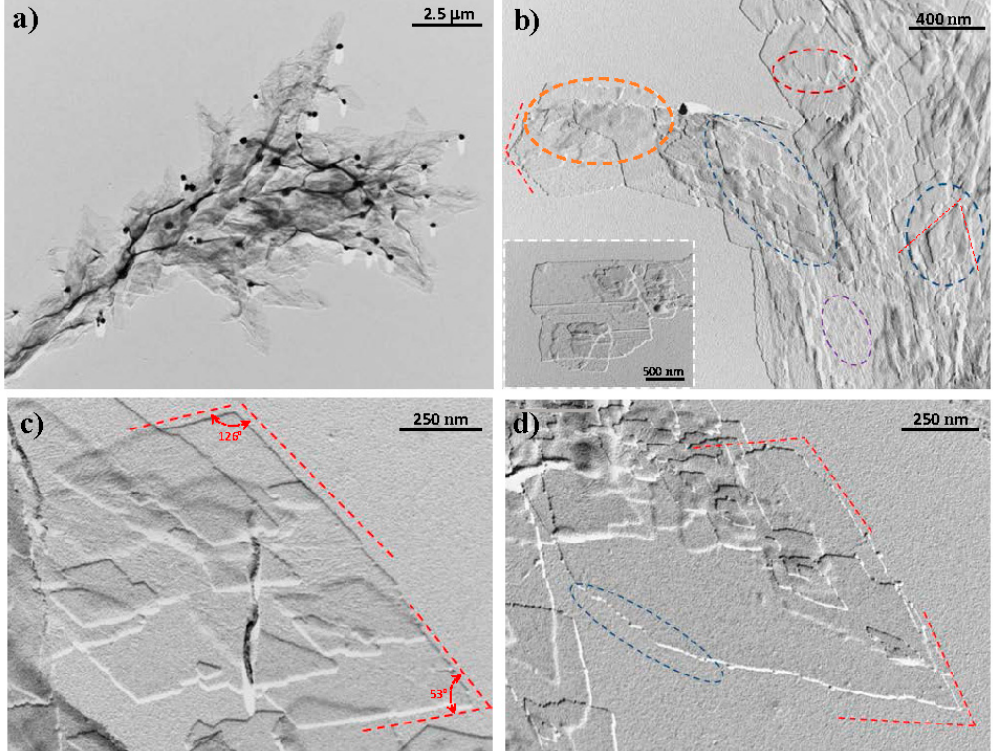
Figure 2. Transmission electron micrographs of nylon 4 9 crystals obtained from dilute glycerin solutions, illustrating the influence of crystallization conditions on morphology: ( a ) Arm of an spherulitic aggregate obtained at 90 °C. ( b ) Aggregates constituted by planar crystals obtained at 110 °C. Blue ellipsoid shows the presence of rhombic crystals whereas the orange ellipsoid and the inset point out the presence of lath shaped crystals. Serrated faces and globules are marked with garnet and violet ellipsoids, respectively. ( c ) Rhombic lamellar crystals obtained from crystallizations performed at 120 °C. Red dashed lines define the theoretical angles between growth faces. ( d ) Elongated lamellar morphologies obtained at 130 °C. Dashed lines indicate the theoretical growth faces according to the expected rhombic morphology. Obtuse angles could be recognized although curved morphologies could also be detected (blue ellipsoid).